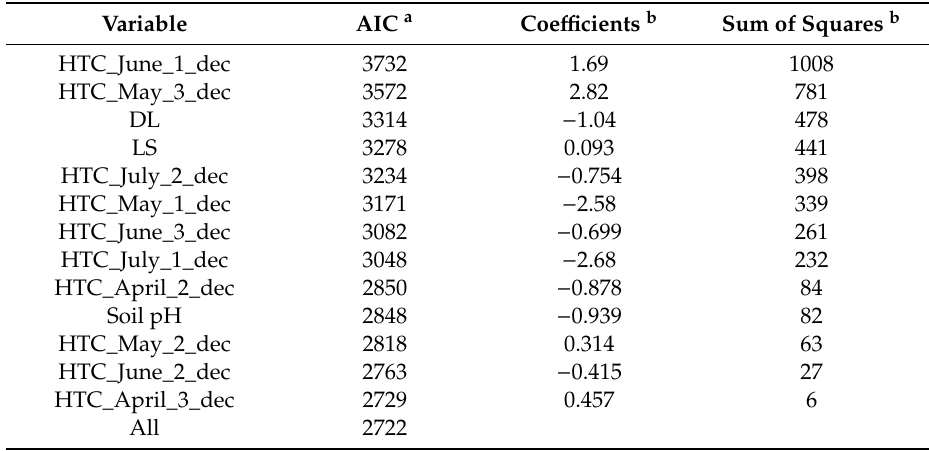
Table 4. Akaike information criterion for sub-models and regression slope (coe ffi cients) for the selected variables in order of significance according to AIC and sum of squares